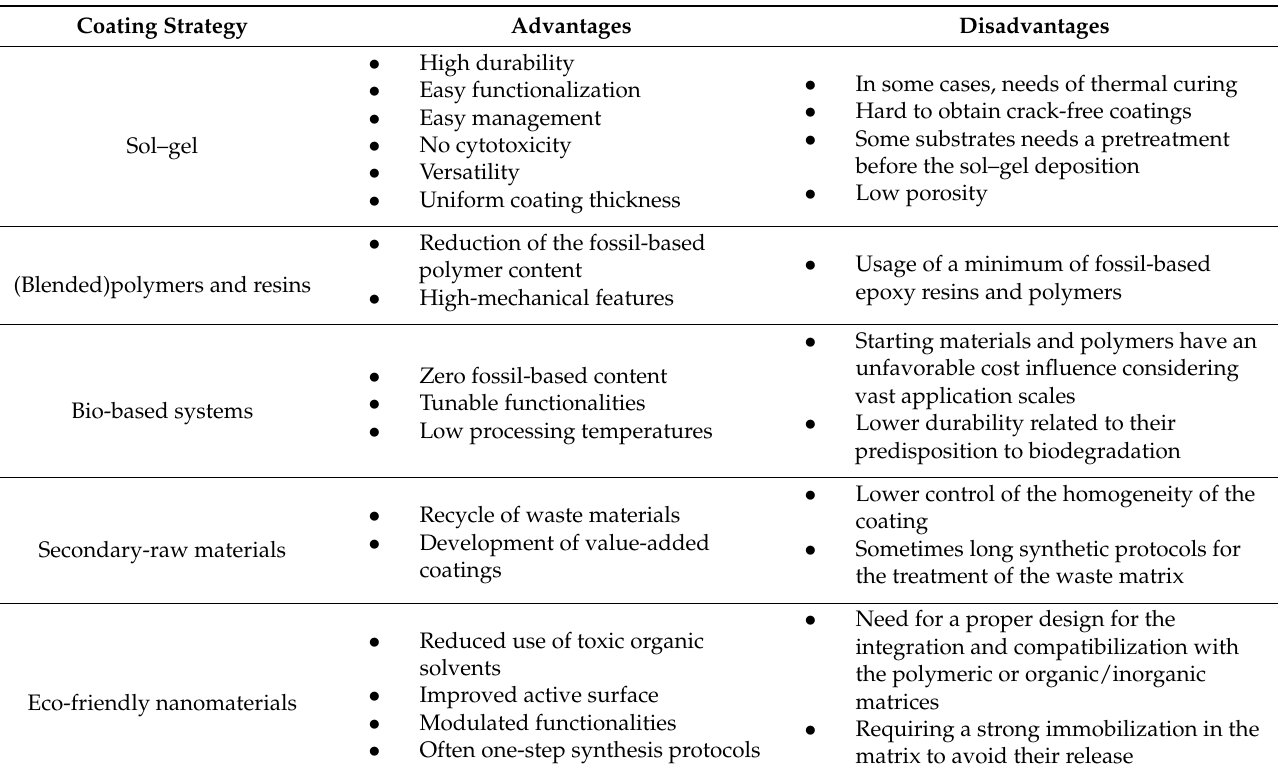
Table 2. Advantages and disadvantages of all reported strategies for sustainable and functional coating